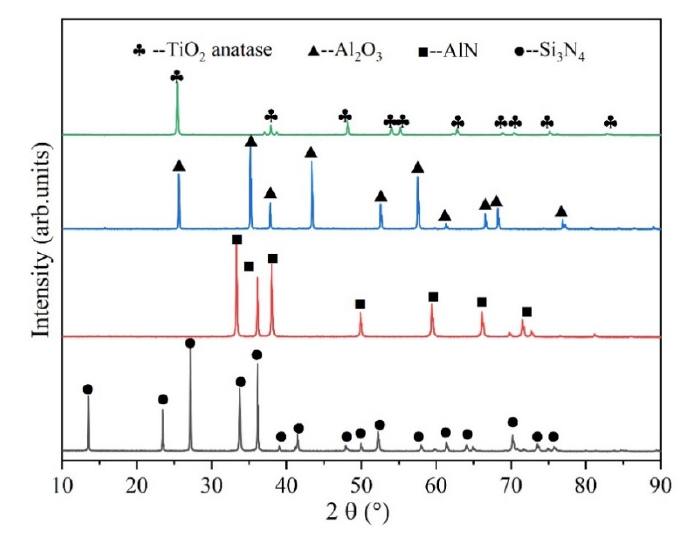
Figure 2. XRD patterns of as-received powders.